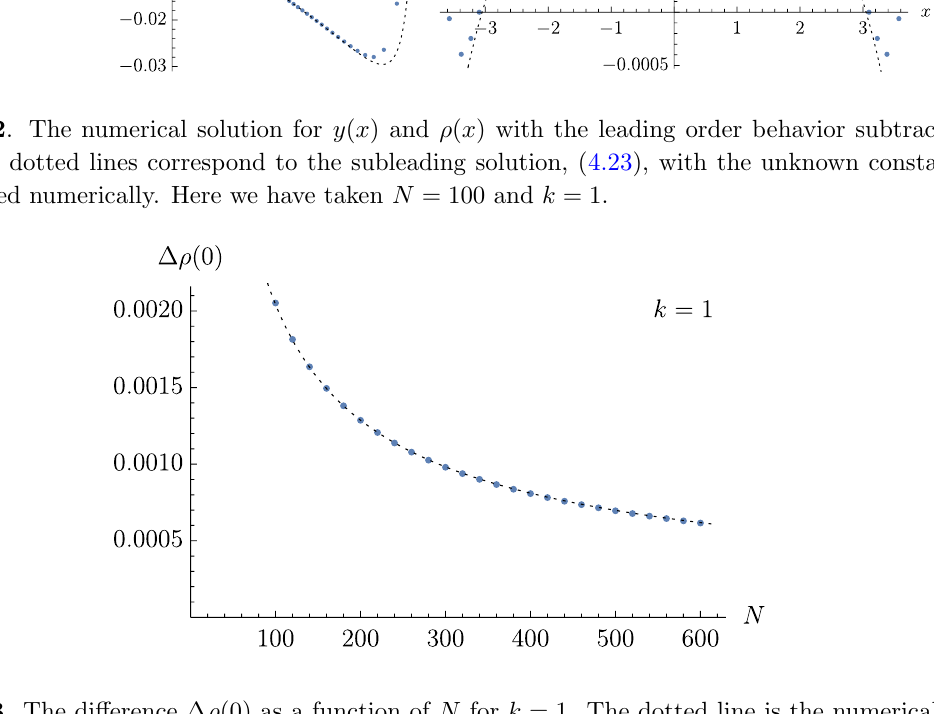
Figure 3 . The di(cid:11)erence (cid:1) (cid:26) (0) as a function of N for k = 1. The dotted line is the numerical (cid:12)t (cid:1) (cid:26) (0) = 0 : 0440 =N 2 = 3